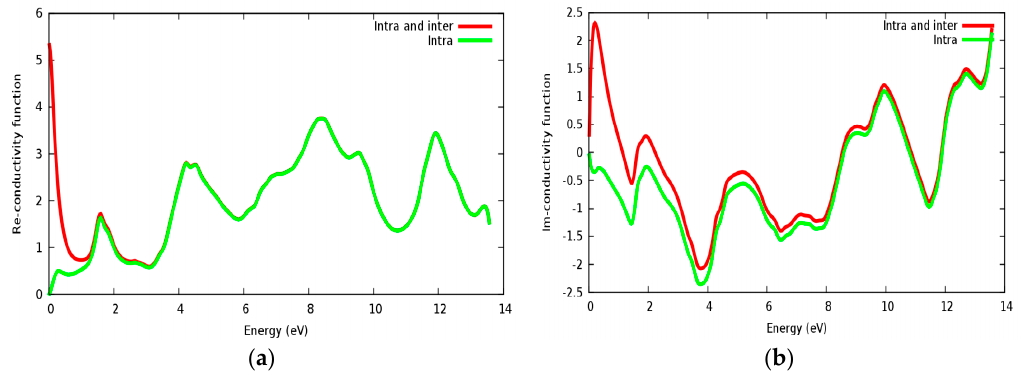
Figure 10. The conductivity function of SrRhO 3 compound: ( a ) Real part; ( b ) Imaginary part.